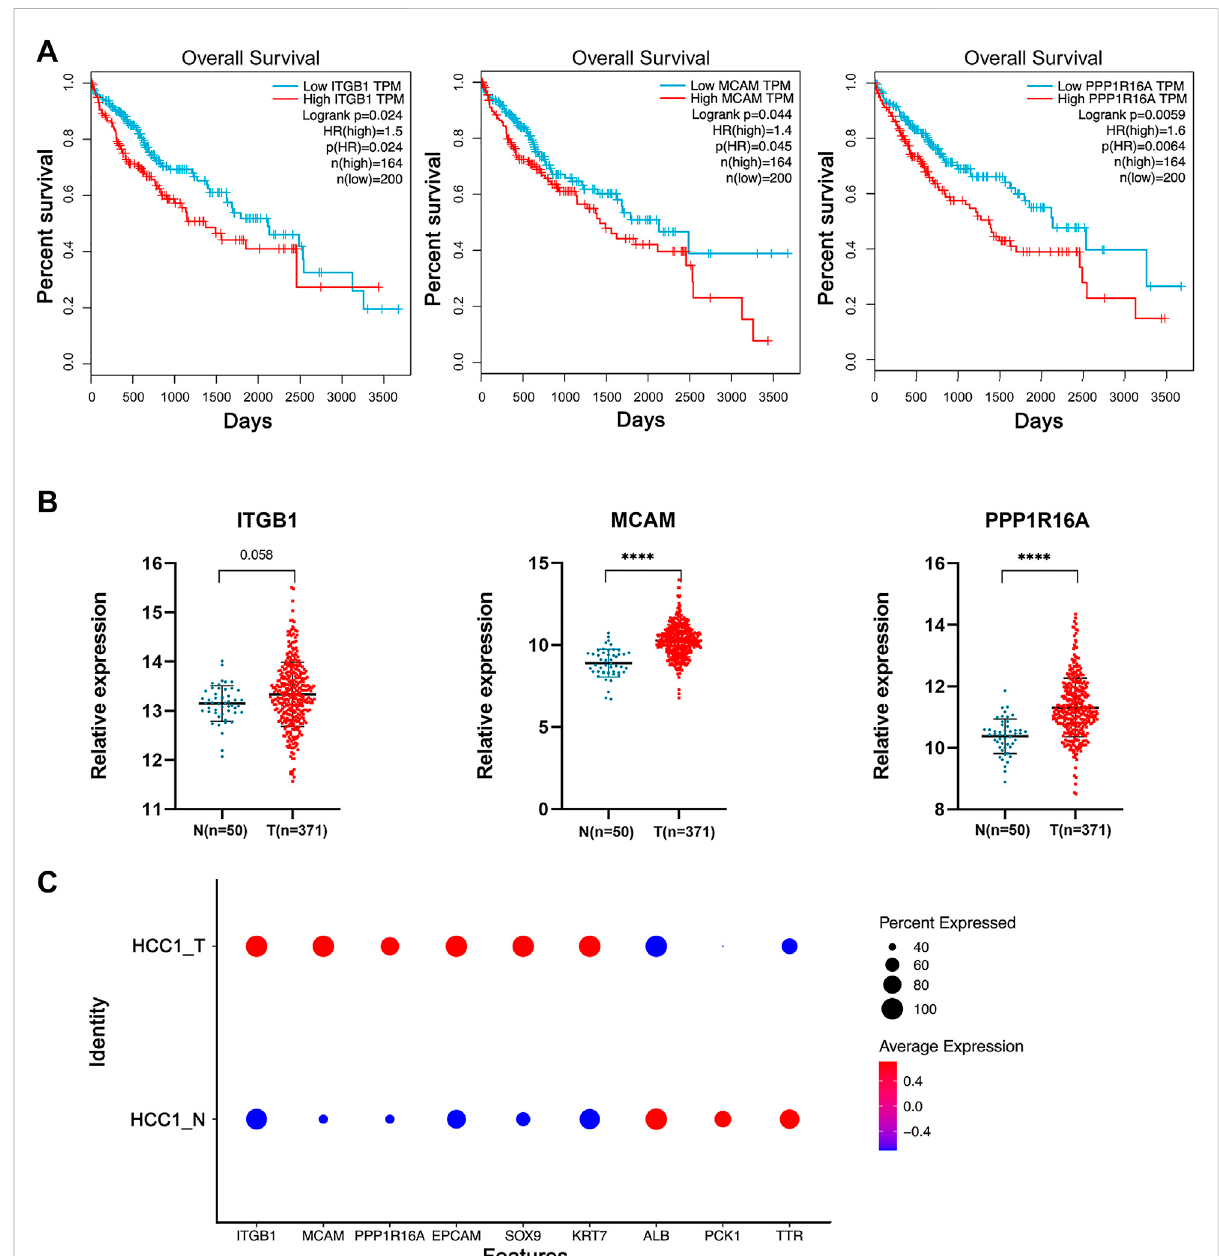
FIGURE 4 Identi fi cation of a 3-gene signature signi fi cantly upregulated in HCC tumor cell subpopulations. (A) TCGA-LIHC samples were divided into high- and low-expression groups based on a gene median expression level. Kaplan – Meier survival curves of the two groups were plotted, and the log-rank p value of the survival difference was calculated. In total, 55% was used as the cutoff value for patient subgrouping. (B) TCGA database differentialexpressionpro fi les between tumor tissues andthenormal liver tissuesweregeneratedbased onthenormalizedexpressionvalueof RNA-seq data. Independent student ’ s t -test, ****, p < 0.0001. (C) Average expression and the percentage expressionof the selected signature genes in whole-cell